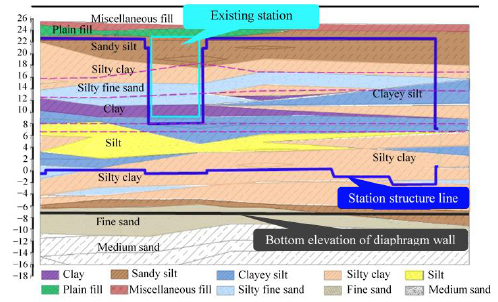
Figure 2. Engineering geological profile.